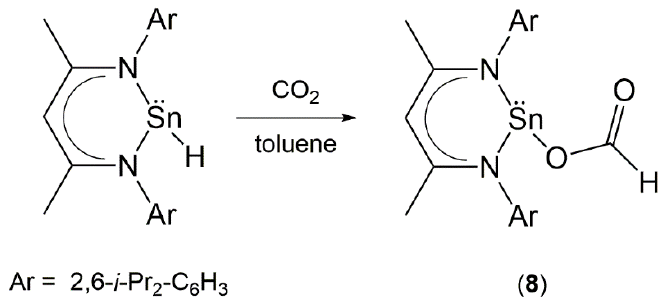
Scheme 16. Reaction scheme leading to Compound 8 , data from [62].